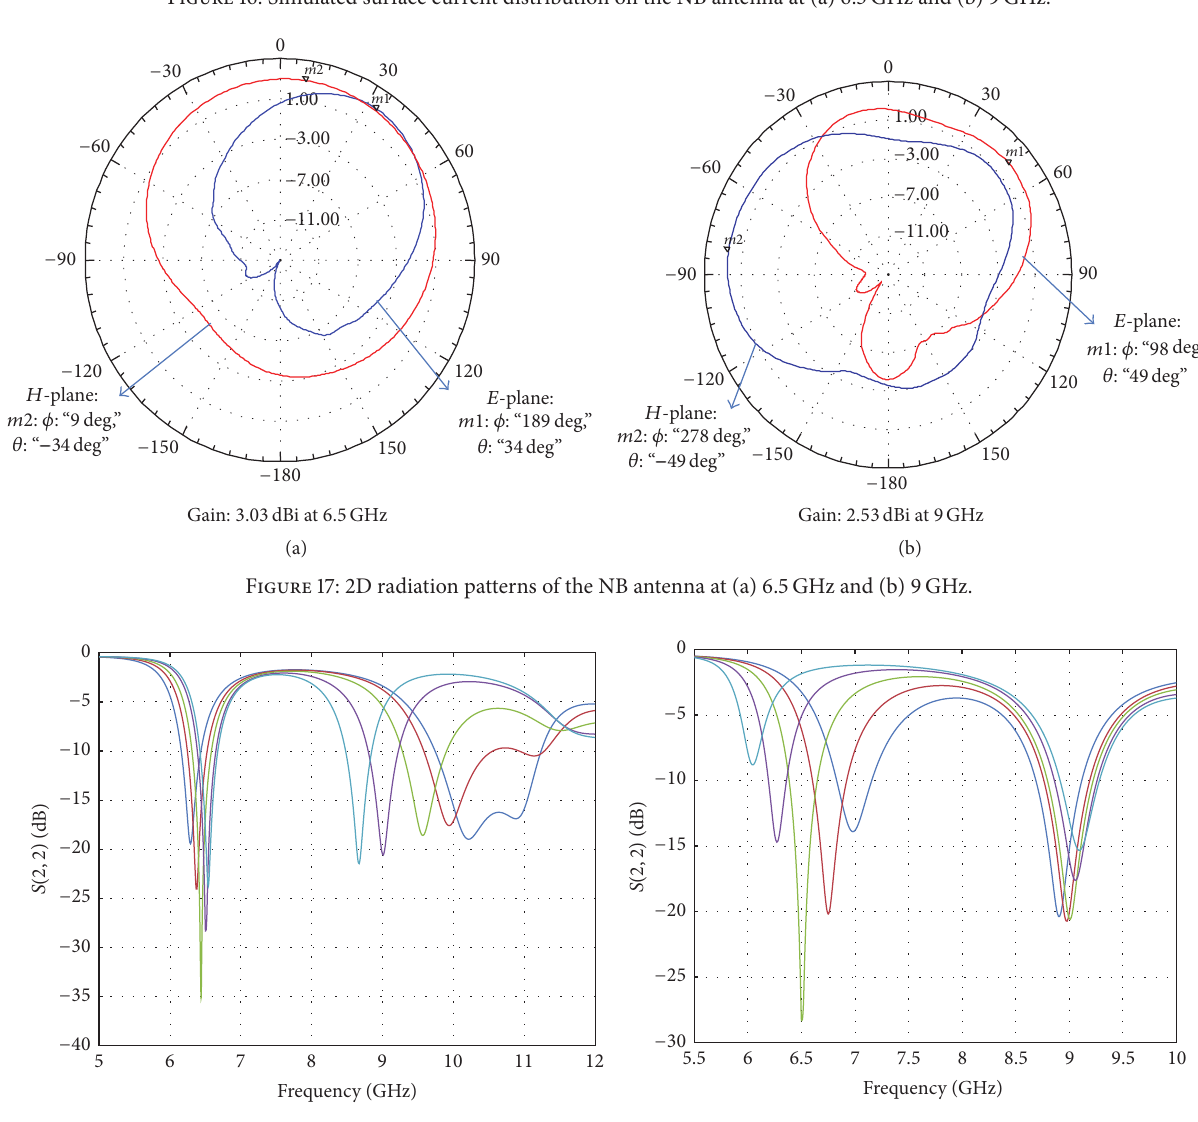
Figure 16: Simulated surface current distribution on the NB antenna at (a) 6.5 GHz and (b) 9 GHz.